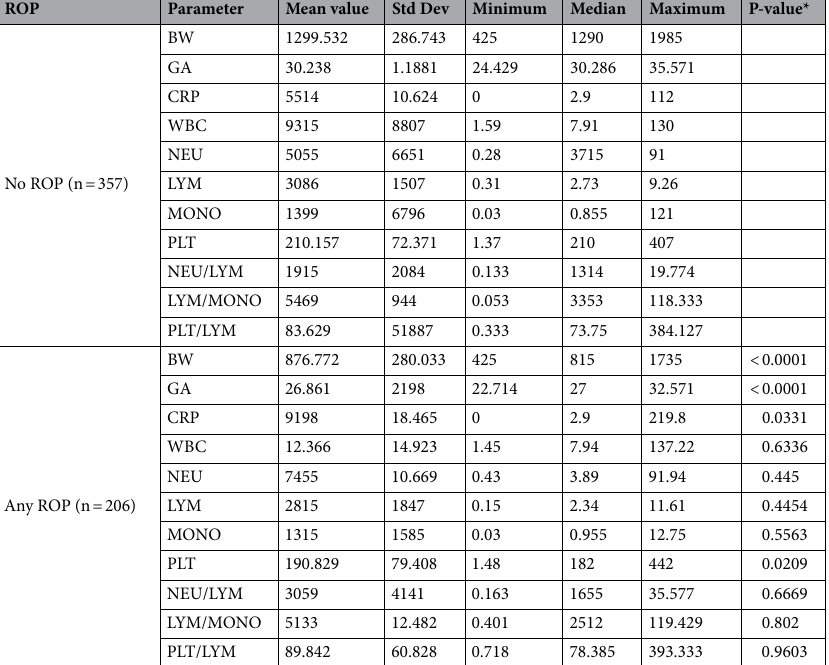
Table 1. Comparison of mean birth weight, gestational age and blood parameters measured in infants without and with retinopathy of prematurity. Std Dev standard deviation, ROP retinopathy of prematurity, BW birth weight, GA gestational age, CRP C-reactive protein, WBC white blood cell count, NEU neutrophils, LYM lymphocytes, MONO monocytes, PLT platelets. *ANOVA test adjusted for gestational age, birth weight and small for gestational age.